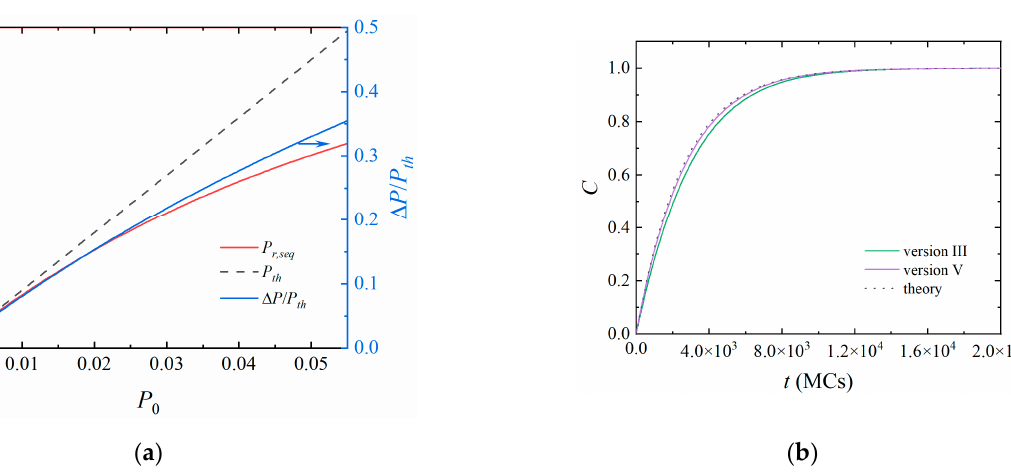
Figure 5. ( a ) The reaction probability P r,seq , P th and the relative difference as a function of P 0 . The number of monomers around each active center is m = 18. ( b ) The conversion of free monomers during the polymerization of a system with randomly distributed initiators. The reaction interval time τ = 10 MCs, and the reaction probability between one active center and one monomer P 0 = 0.05. Other parameters are the same as those in Figure